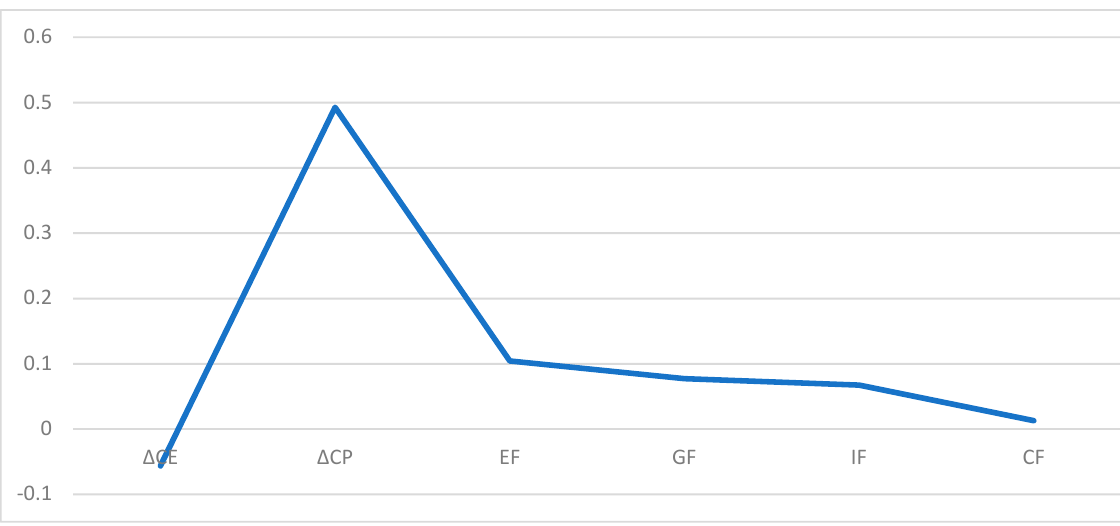
Figure 3. Trend analysis of study constructs along with frequencies.